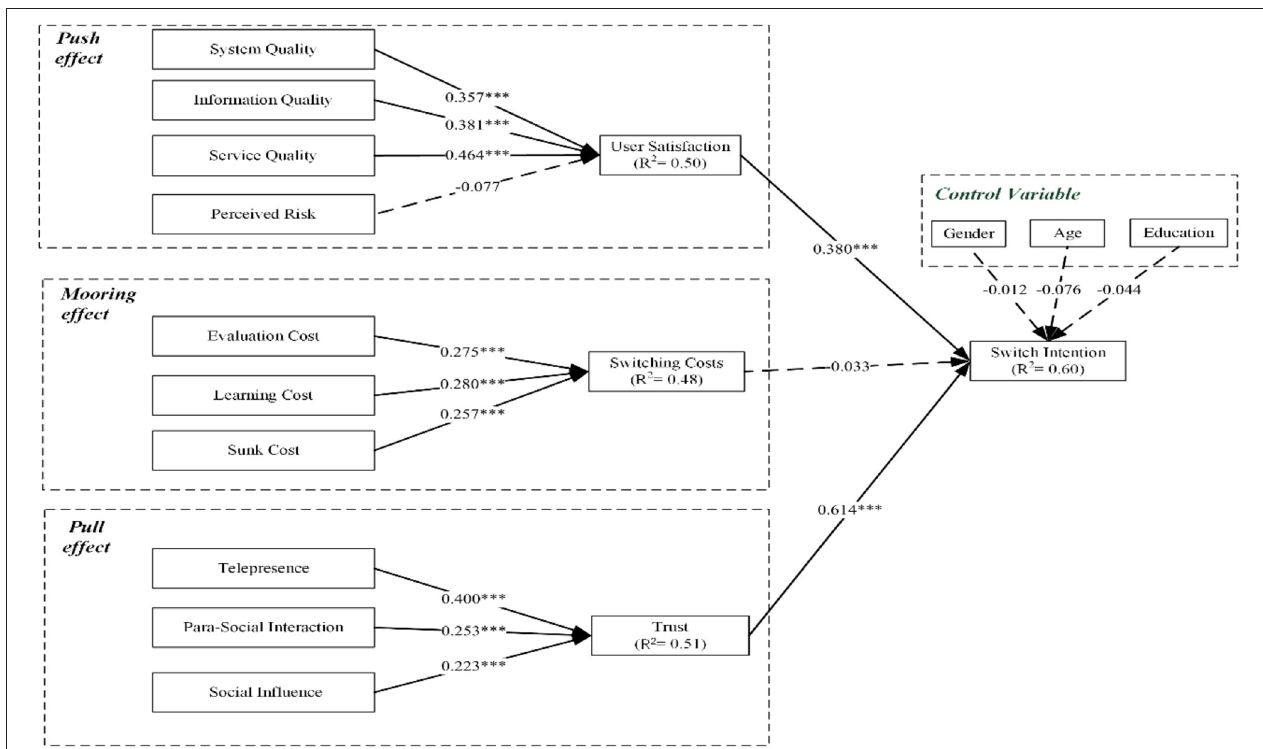
FIGURE 2 | Path analysis of the model. *** p <